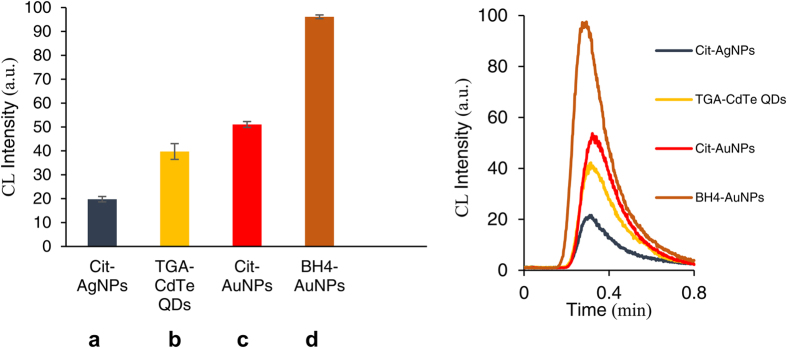
Enhancement effect of the nanoparticles on the CL systems.(a,b) The luminol–H2O2 CL system (0.3 mM luminol, 0.15 M H2O2, 20 rpm flow rate, NaOH concentration of luminol solution = 0.01 M). (c,d) The luminol– AgNO3 CL system (0.5 mM luminol, 25.0 μM AgNO3, 20 rpm flow rate, NaOH concentration of luminol solution = 0.1 M).